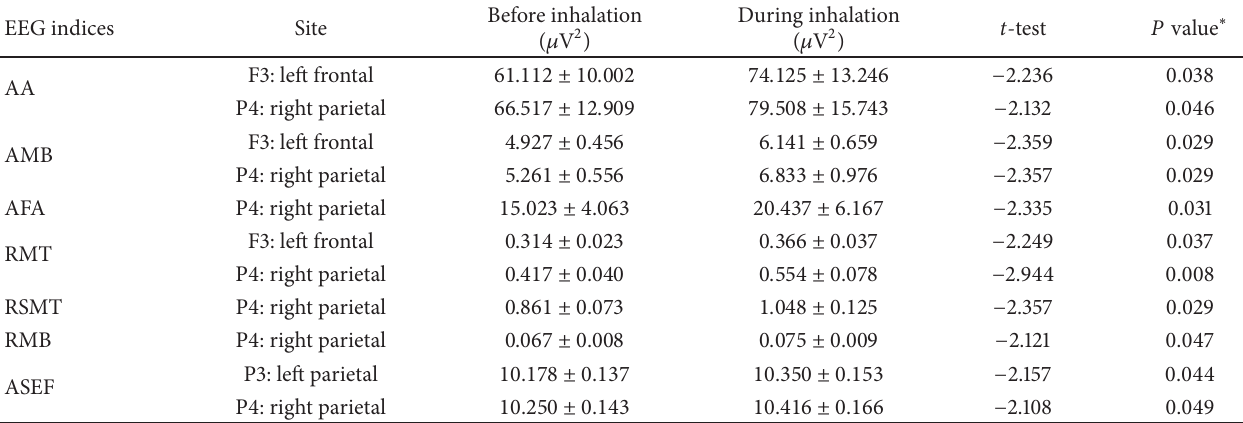
Table 3: Effect of binasal inhalation of essential oil of A. koreana twigs on EEG activity in both